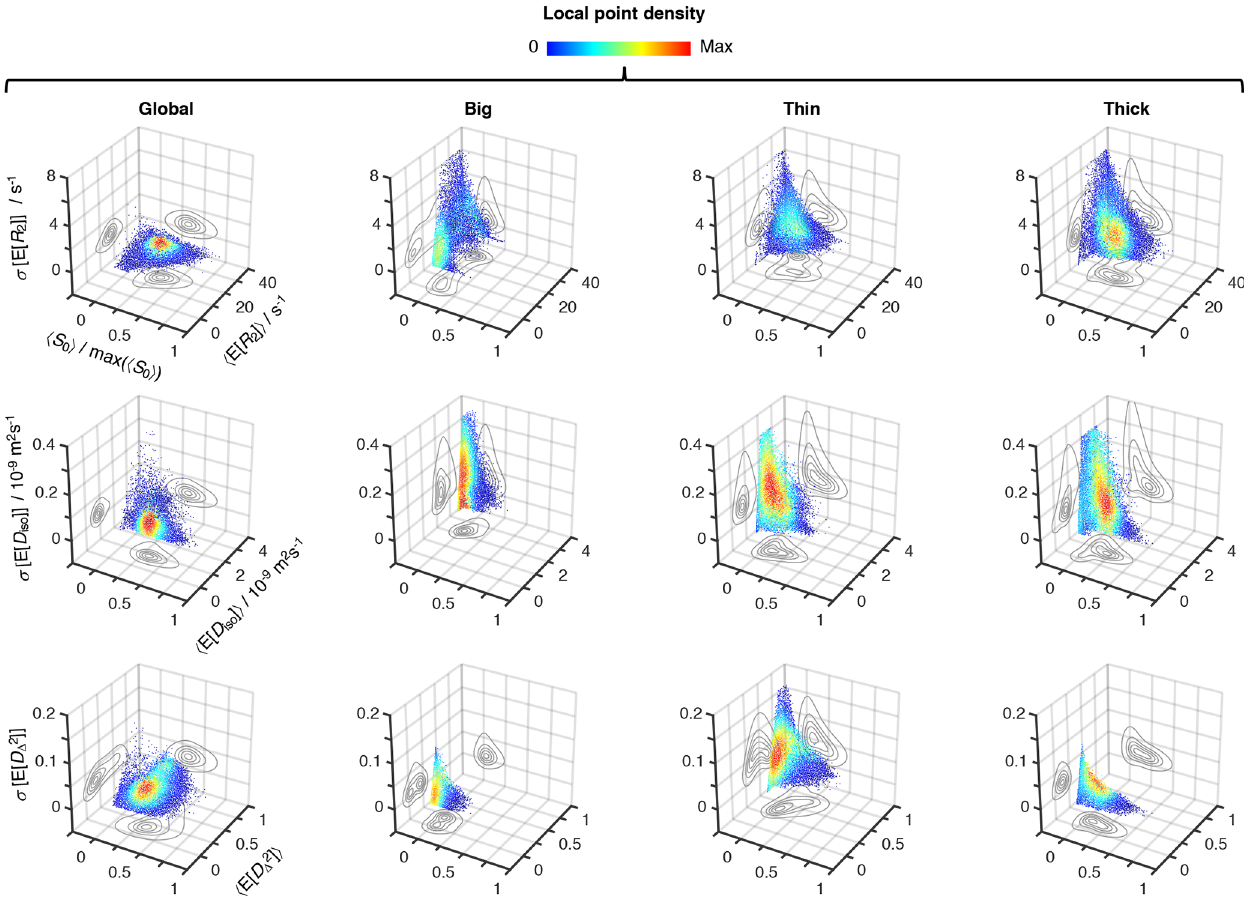
Figure 5. Uncertainty estimation of the statistical measures derived from the relaxation–diffusion distributions. 3D density (color) scat- ter plots show the relationship between average initial signal intensity (cid:104) S 0 (cid:105) , the average of mean values derived from the R 2 - D distribu- tions (cid:104) E [ x ](cid:105) , and their corresponding uncertainties σ [ E [ x ]] . For display purposes, signal intensity values were normalized to the maximum recorded (cid:104) S 0 (cid:105) , max( (cid:104) S 0 (cid:105) ). The contour lines on the side planes show 2D projections of the point density function defining the distribution of data points. The average mean values of transverse relaxation rate (cid:104) E [ R 2 ](cid:105) (row 1), isotropic diffusivity (cid:104) E [ D iso ](cid:105) (row 2), and squared anisotropy (cid:104) E [ D (cid:49) 2 ](cid:105) (row 3) were computed from all voxels whose (cid:104) S 0 (cid:105) was greater than 5% of max( (cid:104) S 0 (cid:105) ). The resulting dataset comprises 55327 voxels spread throughout all slices of the acquired 3D volume. The uncertainties of (cid:104) E [ R 2 ](cid:105) , (cid:104) E [ D iso ](cid:105) , and (cid:104) E [ D (cid:49) 2 ](cid:105) correspond to the median absolute deviation between measures extracted from 96 independent solutions of Equation (2): σ [ E [ R 2 ]] , σ [ E [ D iso ] ), and σ [ E [ D (cid:49) 2 ]] , respectively. All displayed data were derived from both the entire R 2 - D space (column 1), and the “big” (column 2), “thin” (column 3), and “thick” (column 4) bins defined in Fig.